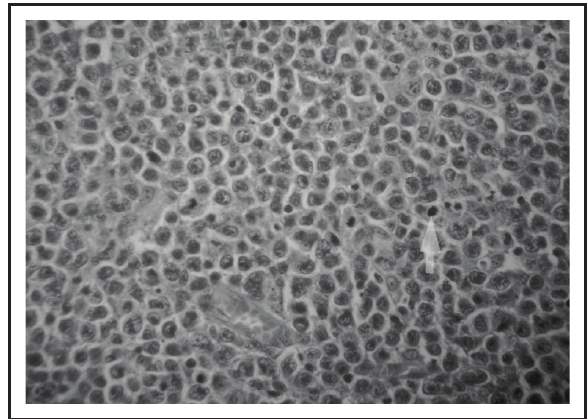
Figure 4. Photomicrograph showing high power view of the lymphoma cells: they are large with high nu - cleocytoplasmic ratio, oval to round to indented, hav- ing irregularly folded nuclei, vesicular chromatin, one to two nucleoli and moderate amount of cytoplasm. Numerous mitoticfigures (green arrow) and few kary - orrhexis are observed (H&E stain,